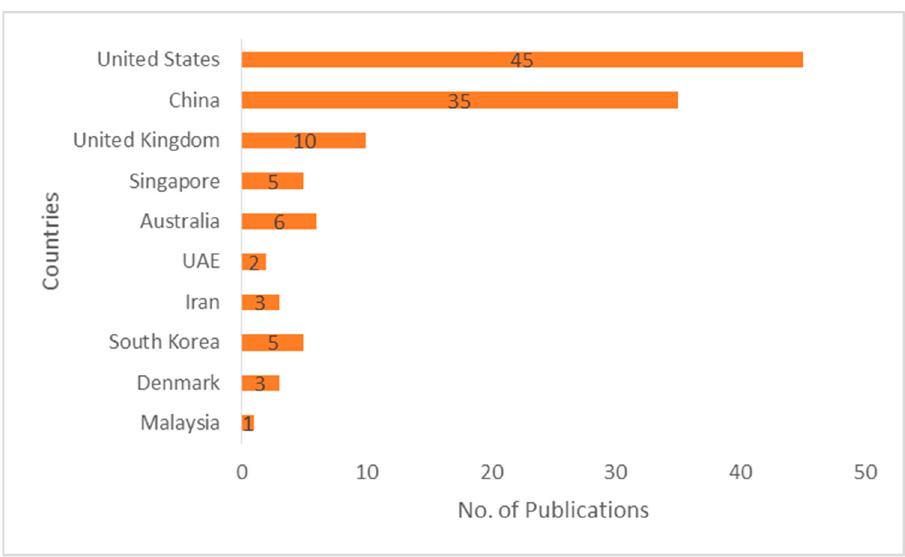
Figure 3. Geospatial distribution of research publications.